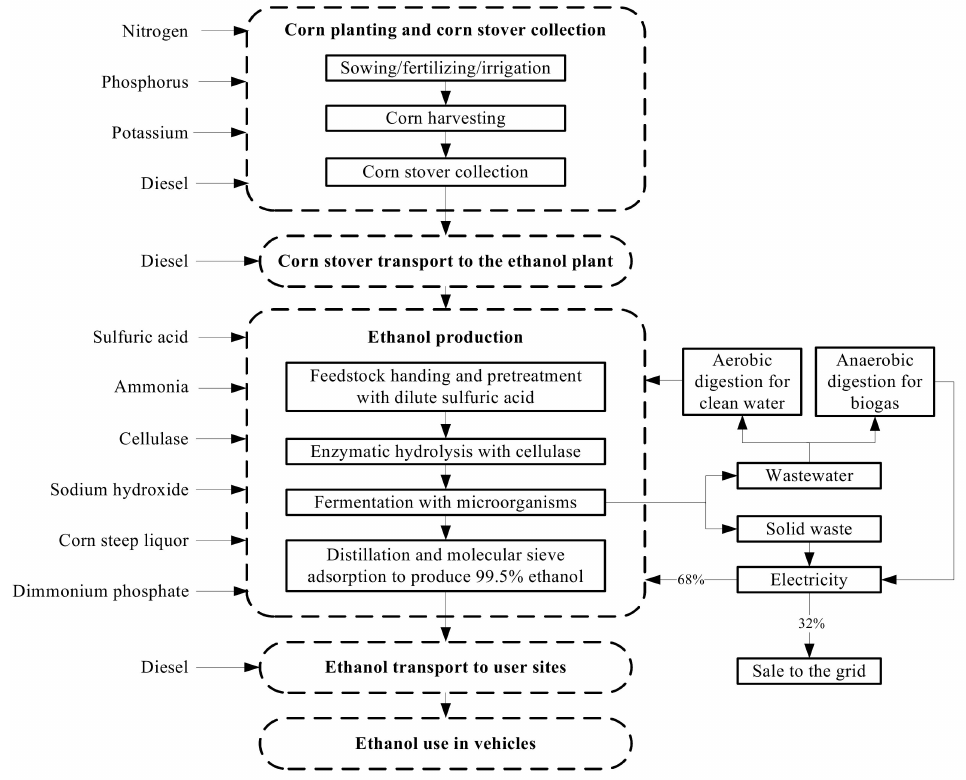
Figure 1. System boundary of the life-cycle assessment of ethanol from corn